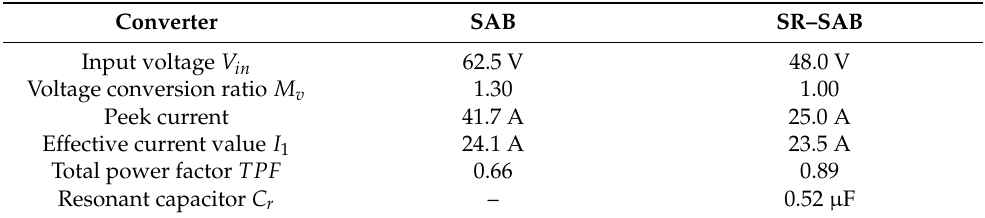
Table 2. Comparisons of characteristics between conventional SAB and proposed SR–SAB converters on 1 kW output power.